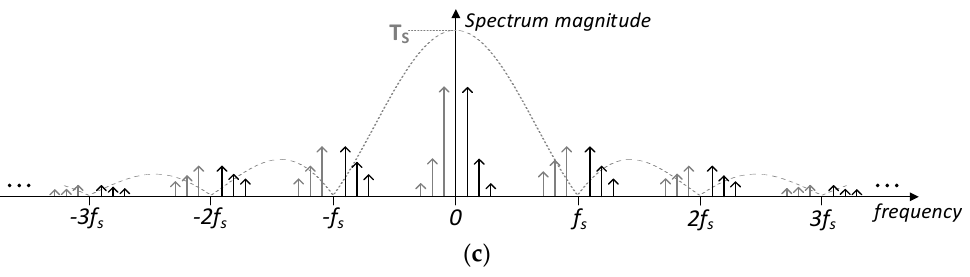
Figure 4. Illustration of the spectrum of a subsampled sinusoidal signal with a frequency f c and considering the presence of second and third-order harmonics. A sampling frequency f s slightly lower than f c is employed: ( a ) spectrum of the original signal; ( b ) spectrum of the ideally subsampled signal, according to Equation (9); and ( c ) spectrum of the subsampled signal by means of an SH circuit, which employs rectangular pulses with a duration T S according to Equations (12) and (13). Spectral lines are scaled by the value at their frequency of the sinc envelope shown by the dotted line.